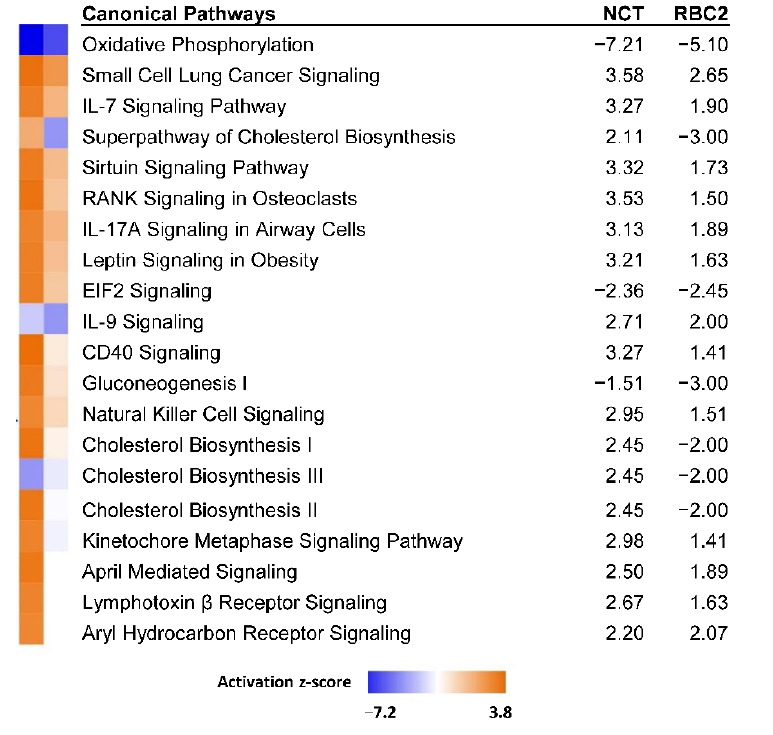
Figure 4. Significant canonical pathways identified in IPA Comparison analysis of genes expressed in NCT versus RBC2 turkey skeletal muscle SCs at 33 ◦ C. Only the 20 pathways with highest composite |z|-scores are